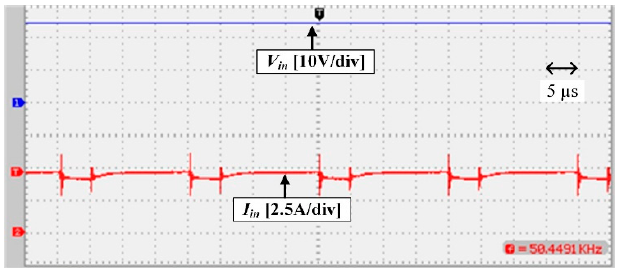
Figure 11. Input Voltage and current of the converter.